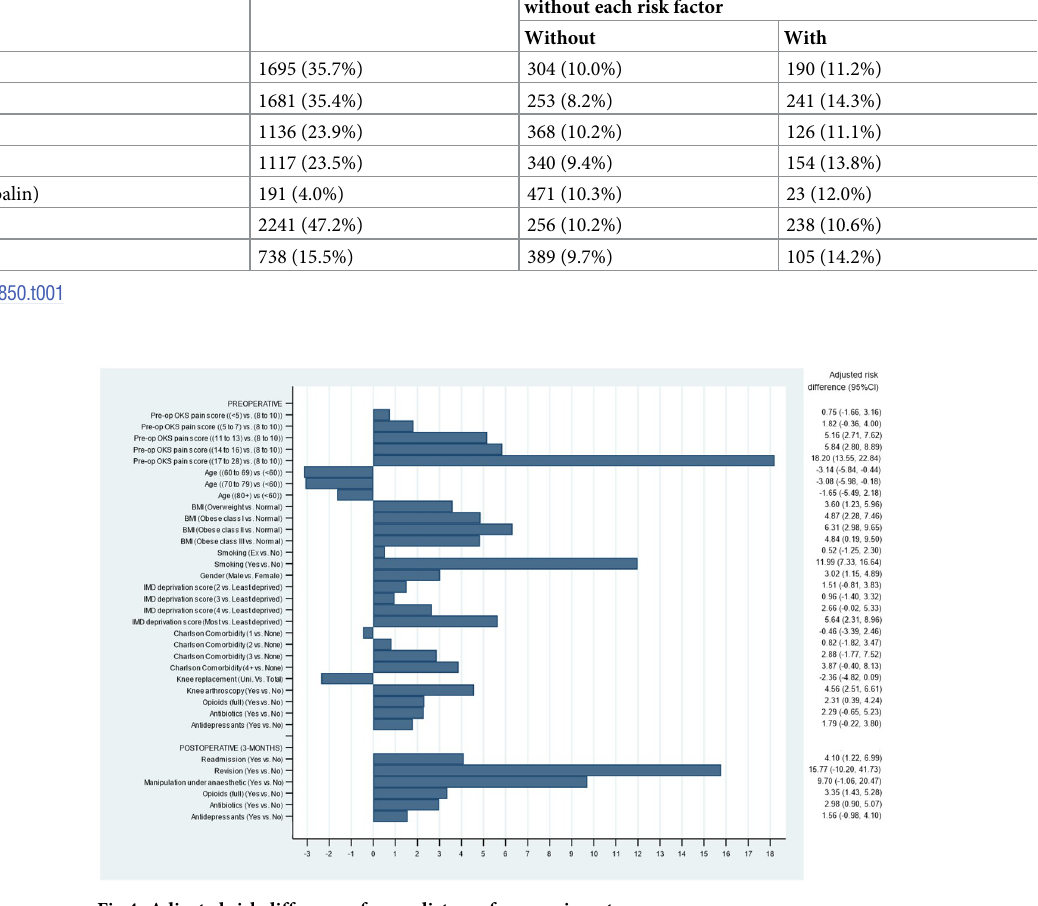
Fig 4. Adjusted risk differences for predictors of poor pain outcomes.